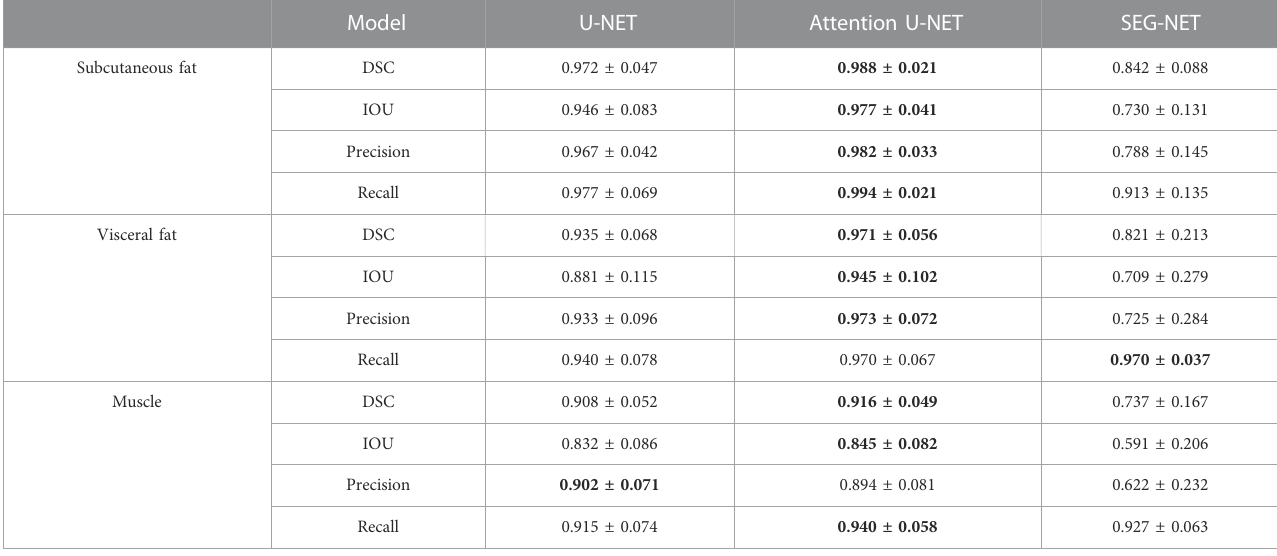
TABLE 3 Statistics of agreement between manual and automatic segmentations in the independent test